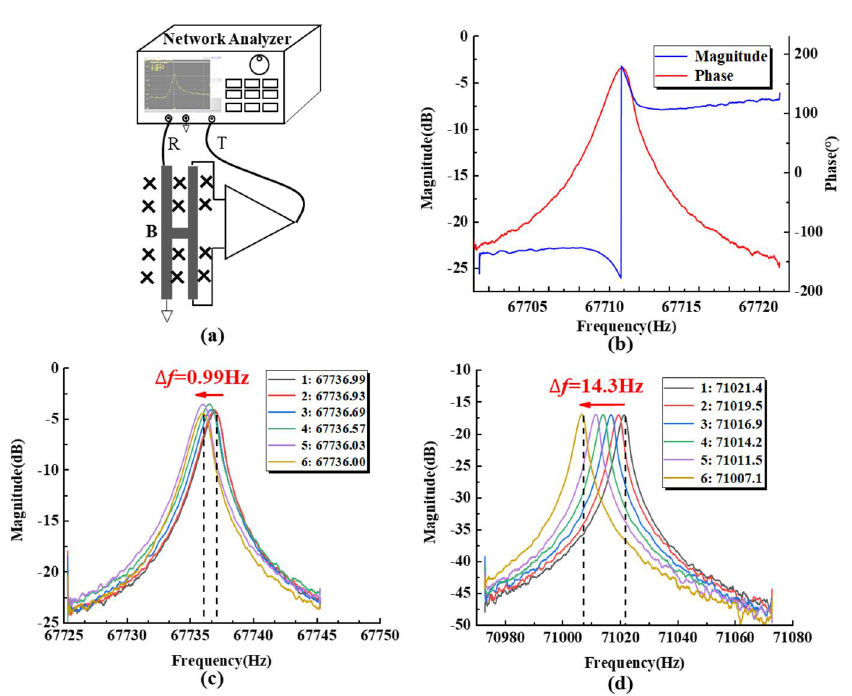
Figure 6. (a) Schematic of the open-loop platform for the resonators; (b) open loop result of the sensor, recording a beam resonant frequency of ~67736Hz (quality factor of 16589); multiple cycles of frequency responses of resonators based on SOG, (c) glass, and (d) vacuum packing.